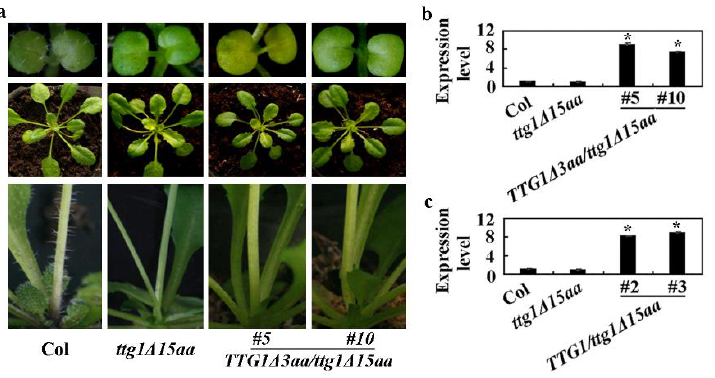
Figure 8. The expression of TTG1 ∆ 3aa under the control of TTG1 native promoter failed to restore trichome formation in the ttg1 ∆ 15aa mutant. ( a ) Trichome formation on leaves of 10-day-old seedlings (up panel), 4-week-old plants (middle panel), and stems of 5-week-old plants (lower panel) of the Col wild type, the ttg1 ∆ 15aa mutant, and the TTG1 ∆ 3aa/ttg1 ∆ 15aa transgenic plants. Seeds of Col wild type, the ttg1 ∆ 15aa mutant, and the TTG1 ∆ 3aa/ttg1 ∆ 15aa transgenic plants were germinated and grown in soil pots. Pictures were taken directly or under a Motic K microscope by using an EOS 1100D digital camera at indicated stages. ( b ) Expression of TTG1 ∆ 3aa in Col wild type, the ttg1 ∆ 15 aa mutant, and the TTG1 ∆ 3aa/ttg1 ∆ 15aa transgenic plants. RNA was isolated from 10-day-old seedlings and qRT-PCR was used to examine the expression of TTG1 ∆ 3aa . The expression of ACT2 was used as an inner control. The expression level of TTG1 ∆ 3aa in the Col wild type was set as 1. Data represent the mean ± SD of three replicates. *, Significantly different from that in the Col wild type (Student’s t test, p < 0.01). ( c ) Expression of TTG1 in Col wild type, the ttg1 ∆ 15aa mutant, and the TTG1/ttg1 ∆ 15aa transgenic plants. RNA was isolated from 10-day-old seedlings, and qRT-PCR was used to examine the expression of TTG1 . The expression of ACT2 was used as an inner control. The expression level of TTG1 in the Col wild type was set as 1. Data represent the mean ± SD of three replicates. *, Significantly different from that in the Col wild type (Student’s t test, p <